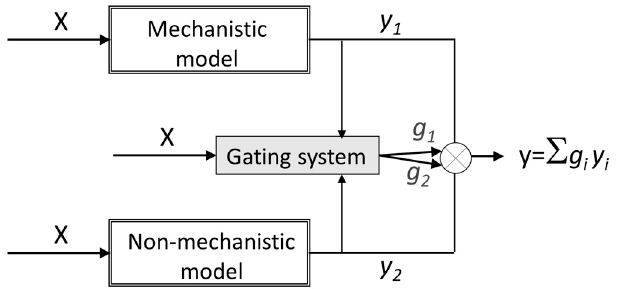
Figure 5. Parallel hybrid modelling using a competitive mixture-of-experts structure, where a gating system selects the contribution of each model to the final prediction. system selects the contribution of each model to the final